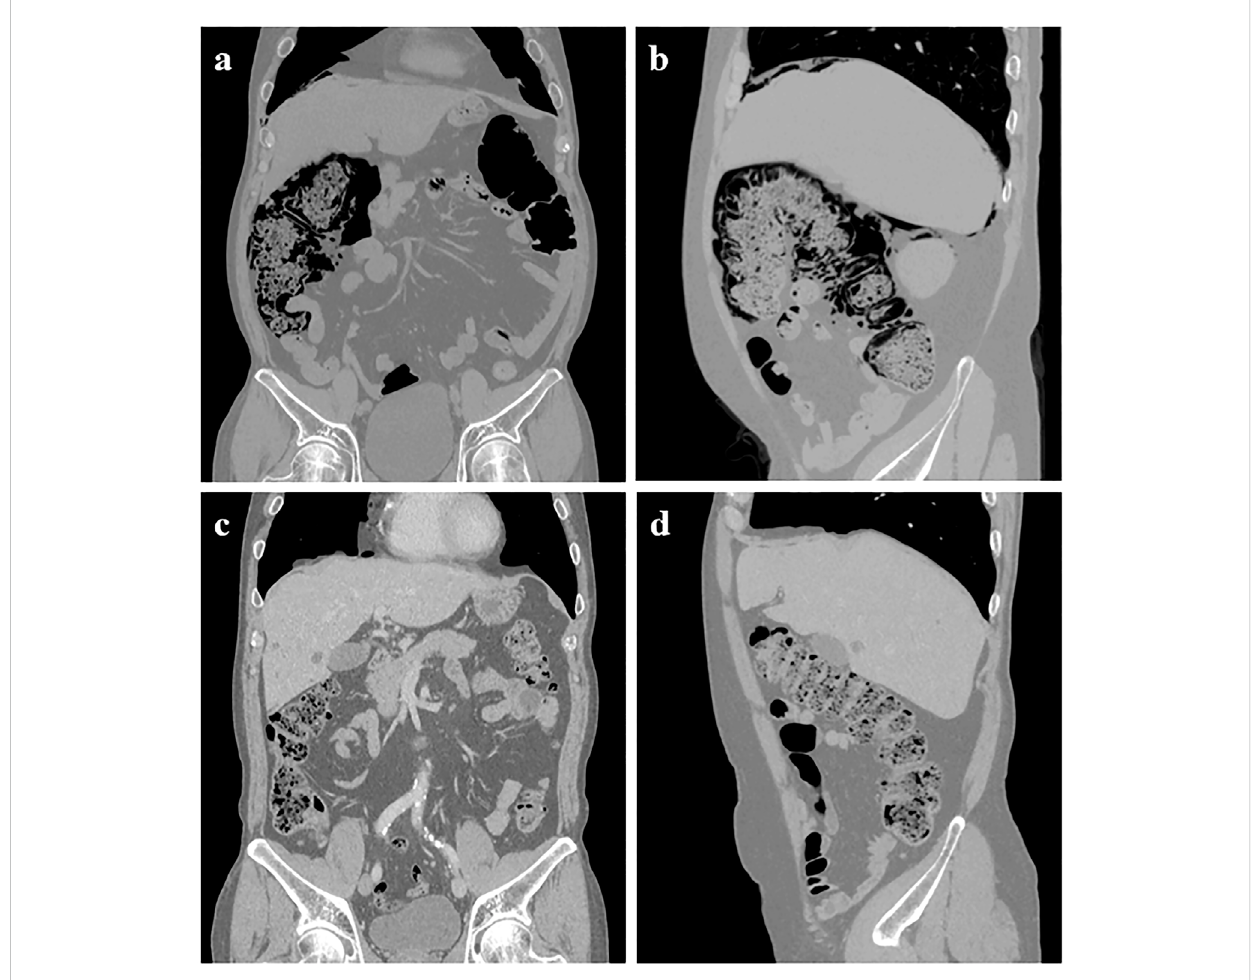
FIGURE 1 Abdominal CT showed pneumoperitoneum under the right diaphragm, extensive intramural air in the ascending colon, and hepatic fl exure with massive air accumulation in the colon 6 weeks after starting high-dose methylprednisolone (A – B) . However, these fi ndings had almost completely disappeared on abdominal CT taken at the outpatient clinic (C – D)